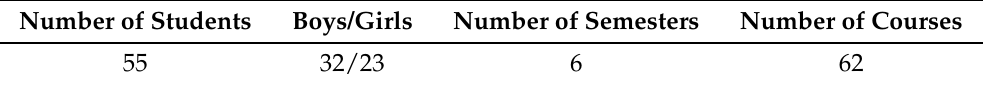
Table 1. Student Personal Information.